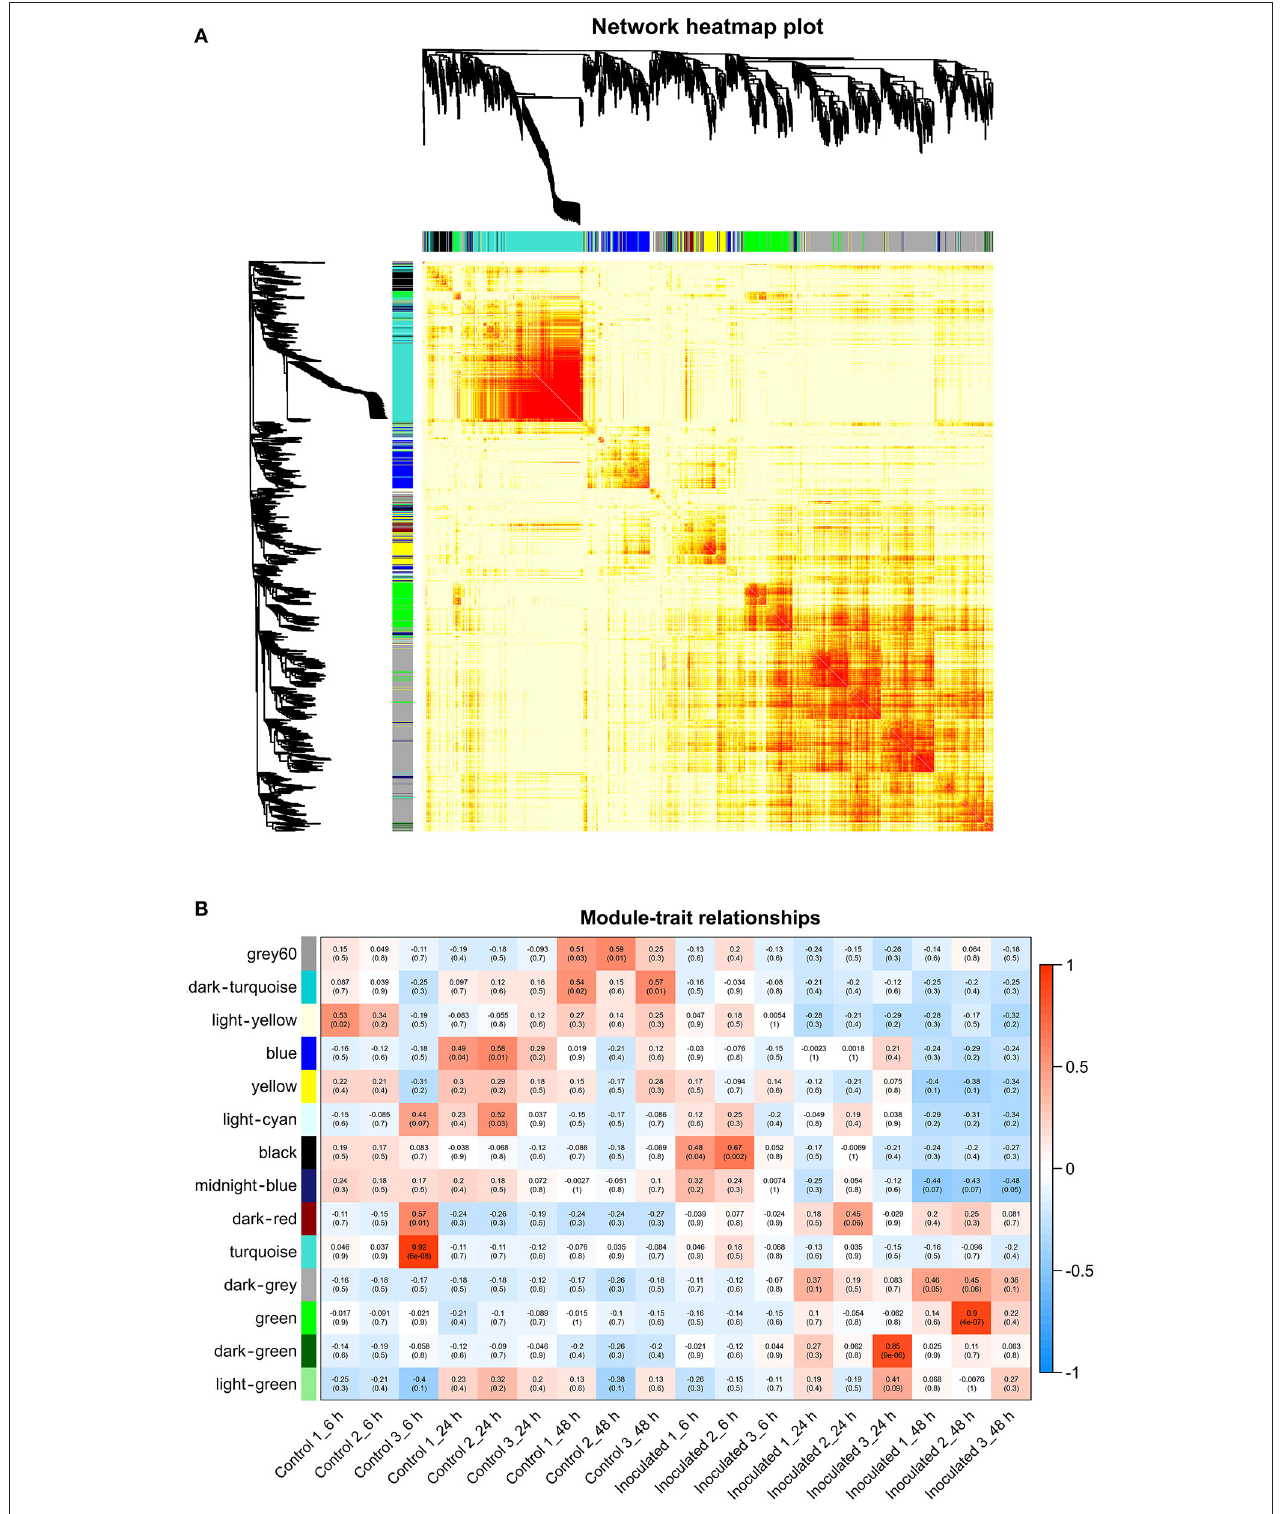
FIGURE 4 | Results of weighted gene coexpression network analysis (WGCNA) of “Sorbonne” transcripts. (A) Dendrogram of genes, based on co-expression network analysis. The gene dendrogram was obtained by hierarchical clustering analysis, with the module color indicated by the color of the row underneath. A total of 14 distinct modules were identified. (B) Association between modules and plant defense traits. The color of each module is the same as that in (A) . Each row in the table corresponds to a module, and each column corresponds to a sample. Values in each cell indicate the number of corresponding correlations and their P -values.